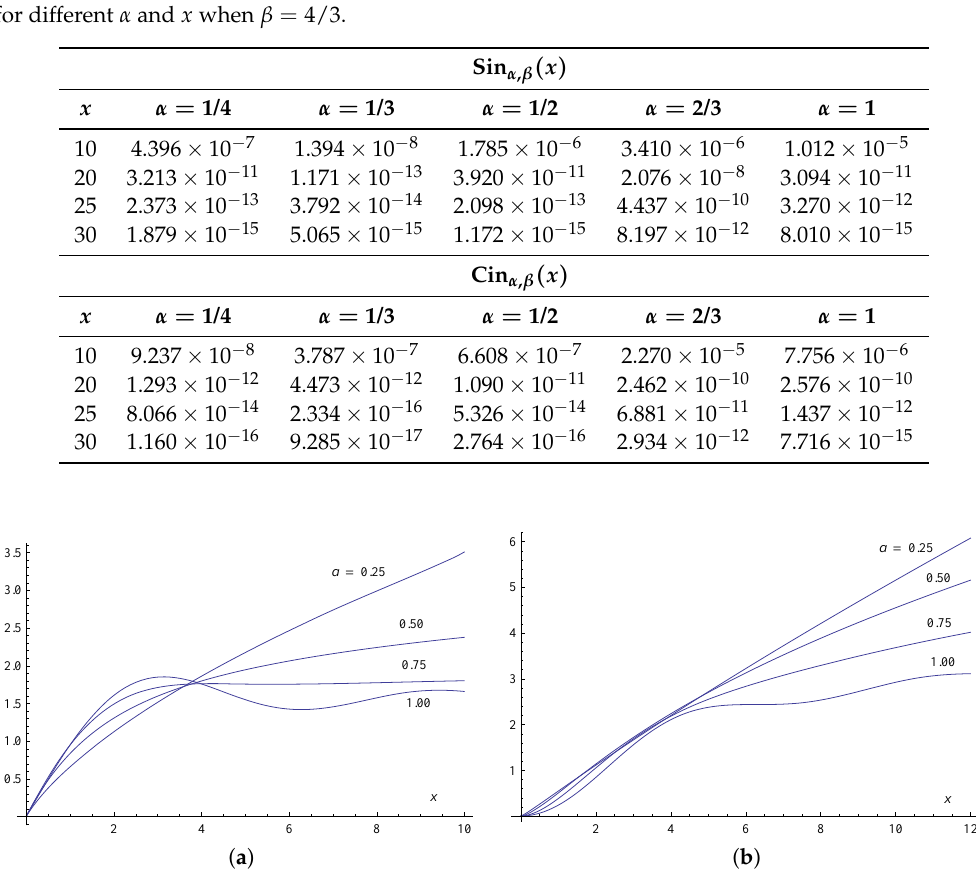
Figure 3. Plots of the generalised sine and cosine integrals ( a ) Sin α ,1 ( x ) and ( b ) Cin α ,1 ( x ) for α = 0.25,0.50,0.75,1.